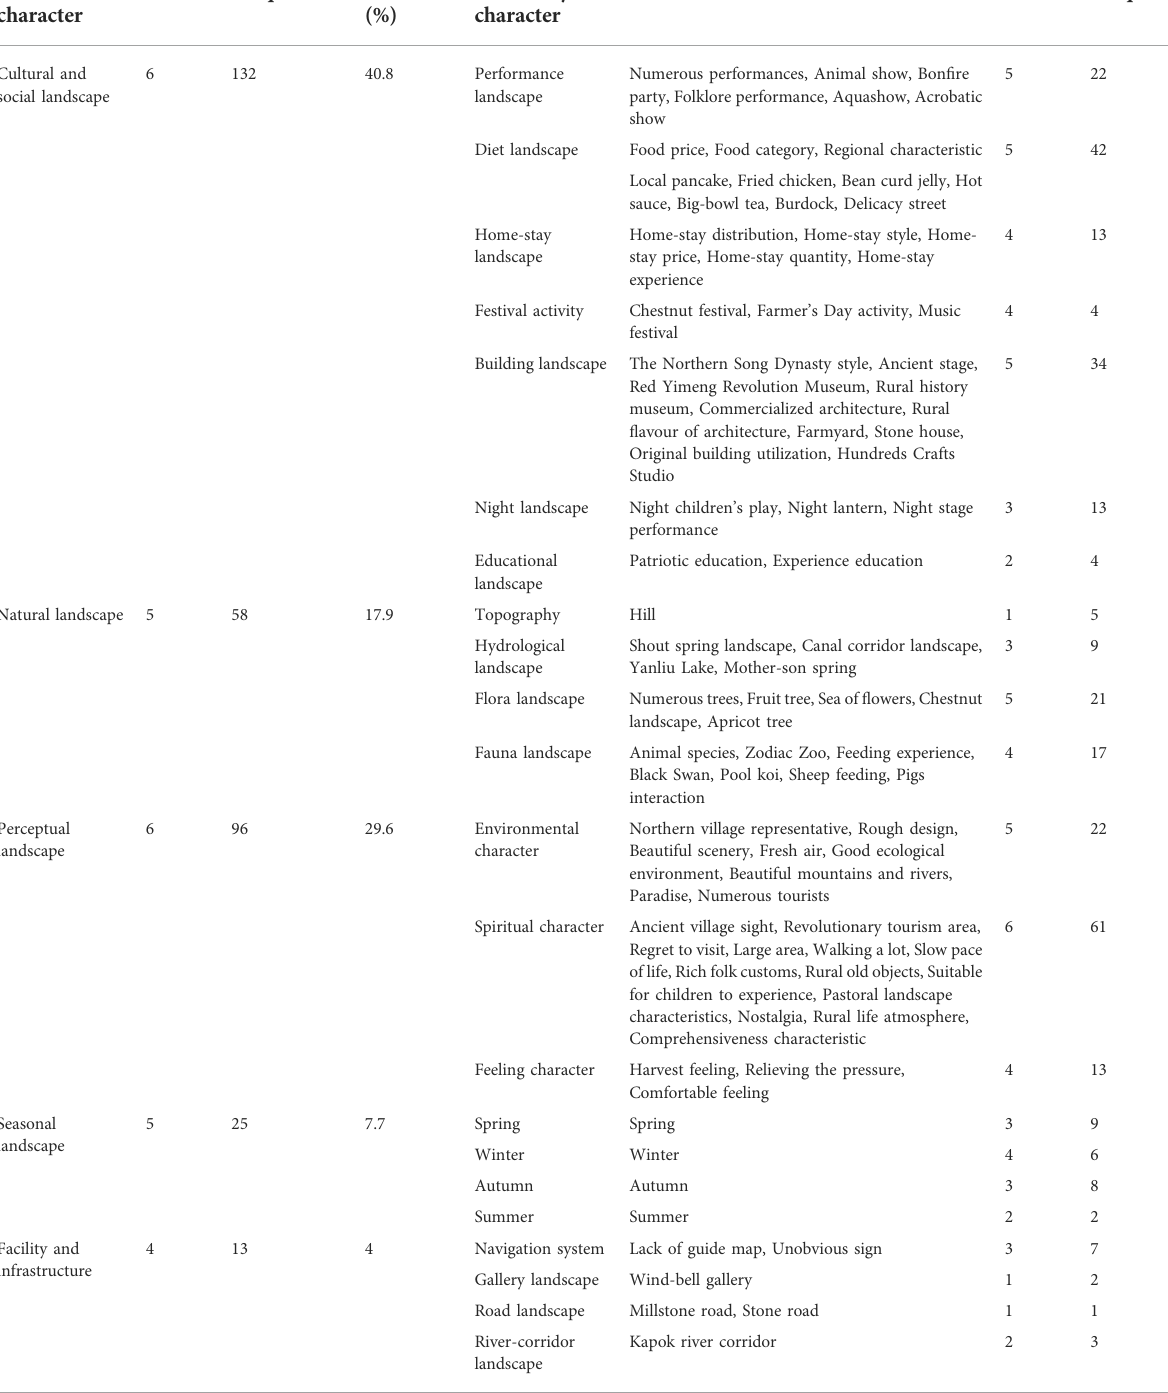
TABLE 3 The main character of landscape in Yayou Gou